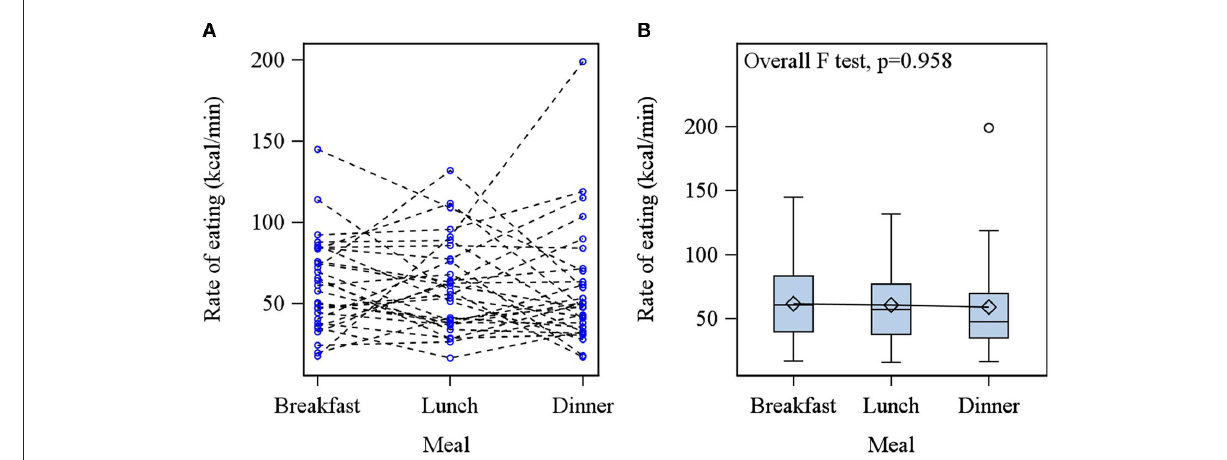
FIGURE4 (A) Individual profile of the rate of eating across meals; each participant is represented by separate dotted lines. (B) The box and whisker plot of rate of eating at each meal. No significant difference in the rate of eating was found between breakfast, lunch, or